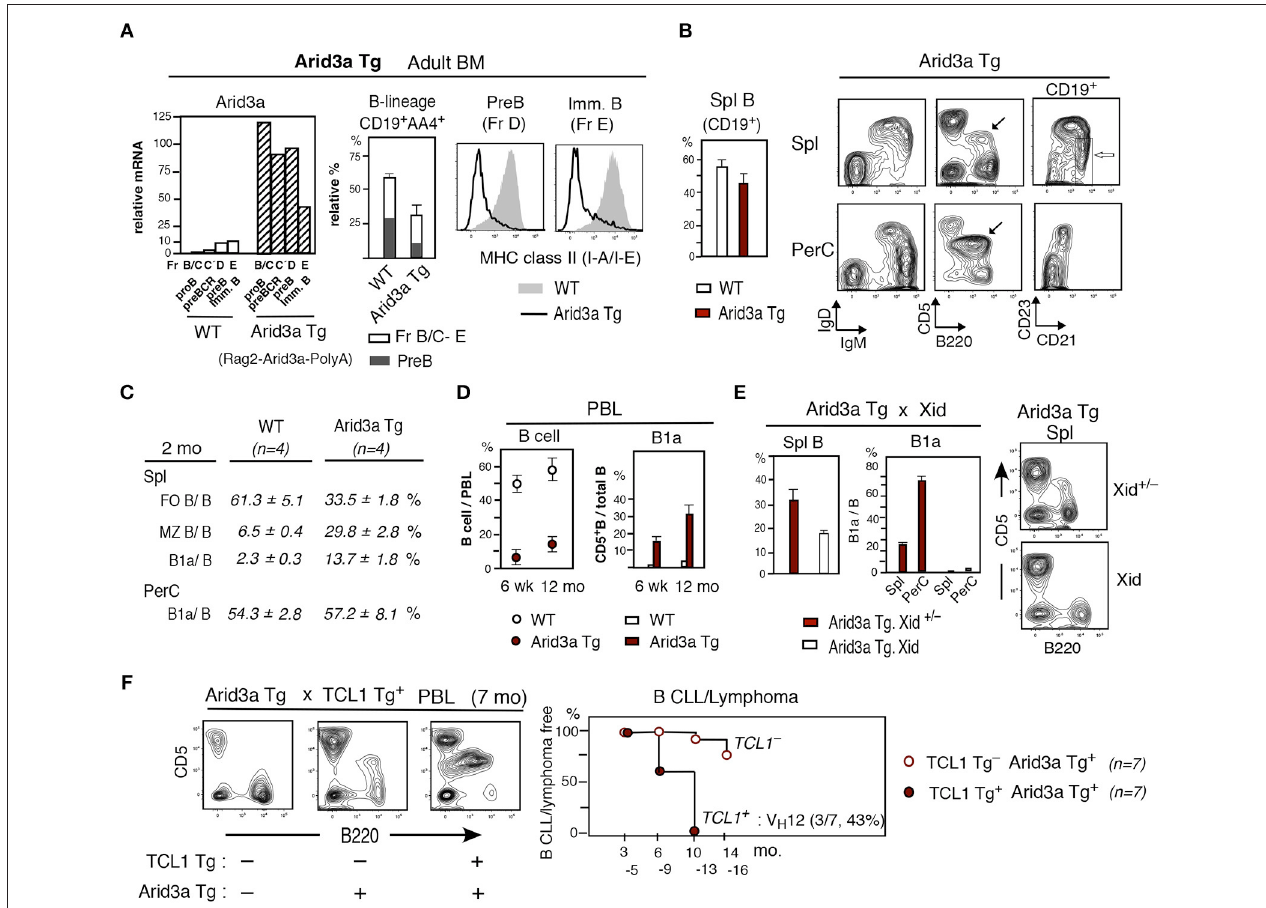
FIGURE 4 | Arid3a Tg mice show reduction of adult BM B cell generation and B1a cell CLL/lymphoma generation in aged mice. (A) Adult Arid3a Tg (Rag2-Arid3a-PolyA) + and Arid3a Tg − (WT) mouse BM. Left: qRT-PCR of 2 mo adult B-lineage (including pre-BCR, Fr.C’). n = 2 each; mean. Middle: relative total CD19 + AA4 + B-lineage (without large myeloid cells) and pre-B cell percentages in 2–4 mo BM. n = 4 each; mean ± s.e. Right: MHC class II staining of pre-B and immature B cells. Representative of 2–4 mo 4 mice each (Arid3a Tg mice were all negative). 2 mo Arid3a Tg.B6 mice also showed decreased total B-lineage and MHC class II in BM. (B) Left: Spleen B cell (CD19 + ) percentage in adult (2–4 mo) Arid3a Tg and WT mice. n = 4 each; mean ± s.e. Right: 2 mo Arid3a Tg mouse spleen and PerC. B1a cells are marked (black) and MZ B cells are marked (white). (C) Percentage of FO B, MZ B and B1a cells in total B cells. (D) PBL B cell percentage, and B1a cells in total PBL B cells of Arid3a Tg + and Arid3a Tg − (WT) mice at 6 wk and 12 mo. n = 6 each; mean ± s.e. (E) Arid3a Tg mice crossed with Xid mice. 2 mo Arid3a Tg + littermates. n = 3 each; mean ± s.e. Xid = homozygous Btk Xid (F) Arid3a Tg mice crossed with TCL1 Tg mice, and PBL analysis. High CLL/lymphoma incidence in TCL1 Tg + (including aPtC V H 12 + BCR lymphoma) vs. TCL1 Tg − Arid3a Tg